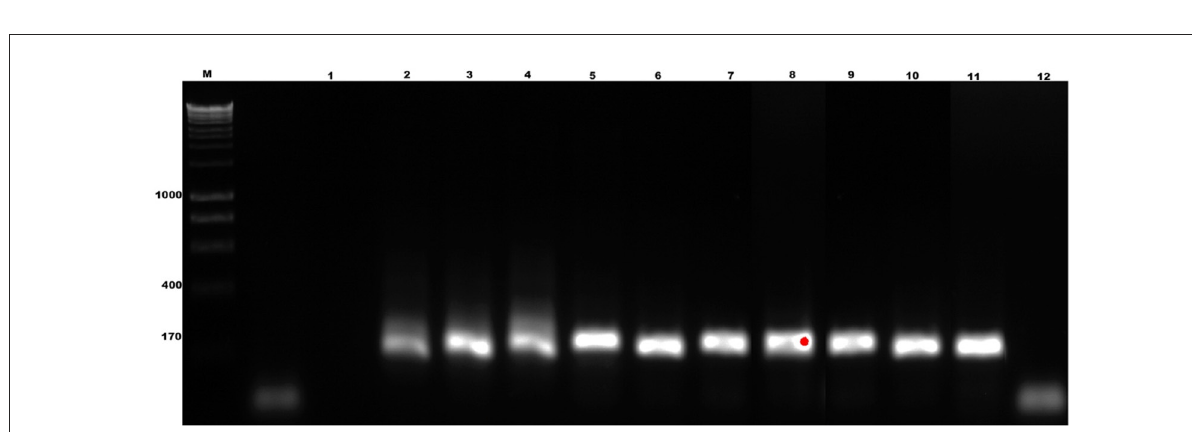
FIGURE6 Sensitivity test of the nested polymerase chain reaction (nPCR) technique, for the detection of B. bigemina . 1.2% agarose gel, redgel stained. Lanes: M) Molecular size marker in bp: (1) Negative control, (2) 2% parasitaemia, (3) 1% parasitaemia, (4) 1 × 10 − 1, ; (5) 1 × 10 − 2 , (6) 1 × 10 − 3 ,